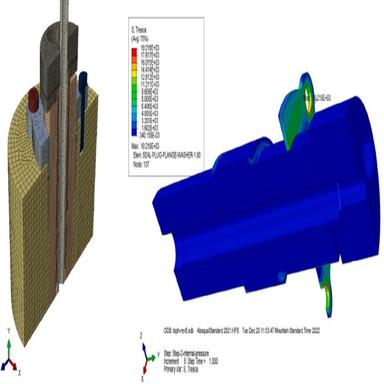
Shows axial cross section views of the IMPACT THCP-MkII sealing hardware ABAQUS model (left), and the ABAQUS Tresca stress results (right).